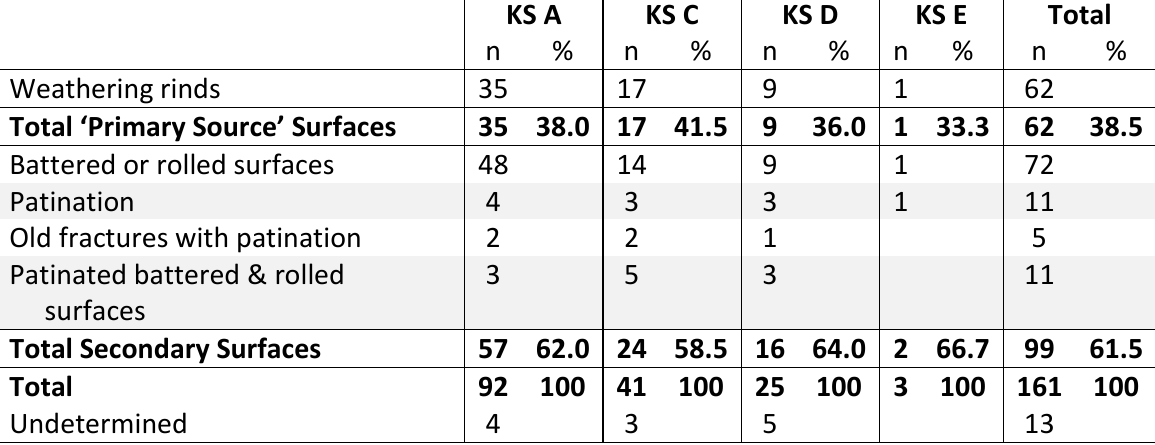
Table 3. Surface features of the Karmir Sar obsidian